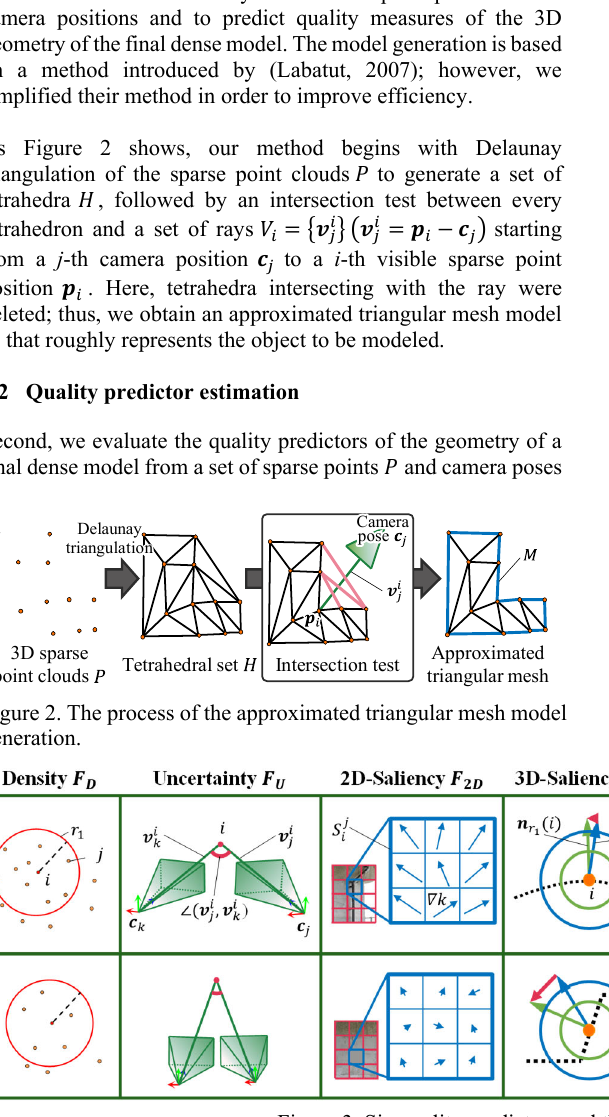
Figure 3. Six quality predictors and the relation between 𝐹 (cid:3025) and 𝐸 (cid:3025) .